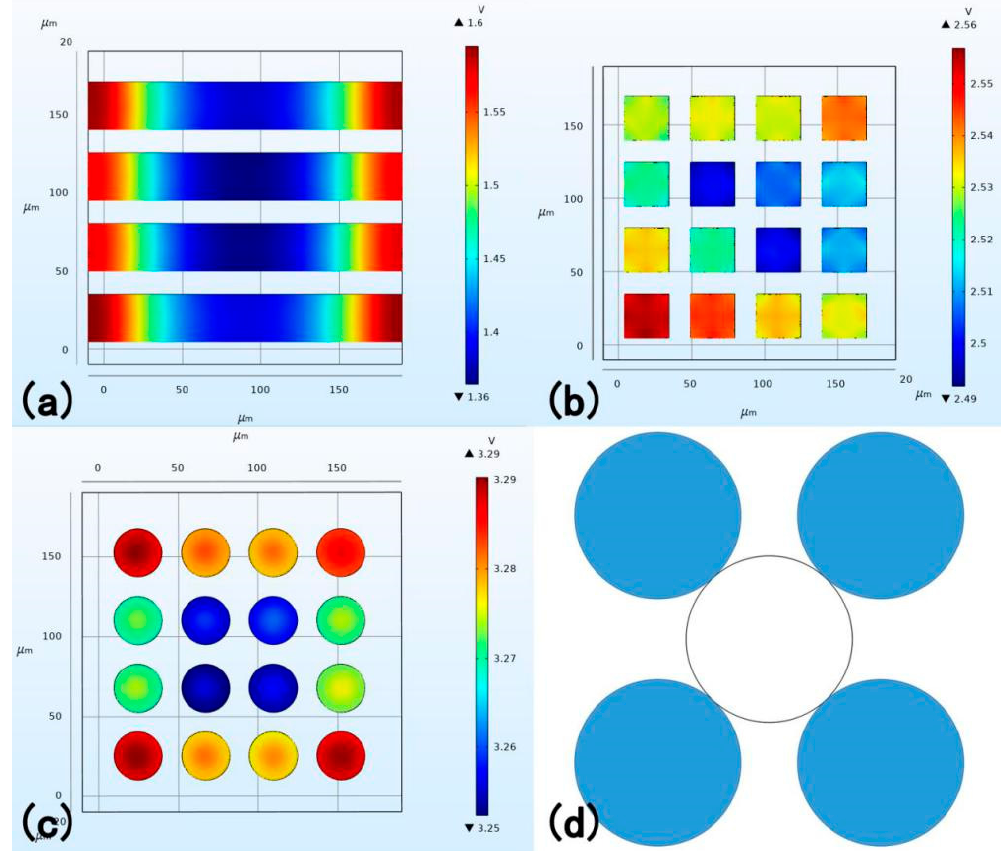
Figure 6. Top view of the voltage. ( a ) Top view of the rectangular groove ( b ) Top view of the rectangular column ( c ) Top view of the cylinder. ( d ) Top view of the cylinder pillar